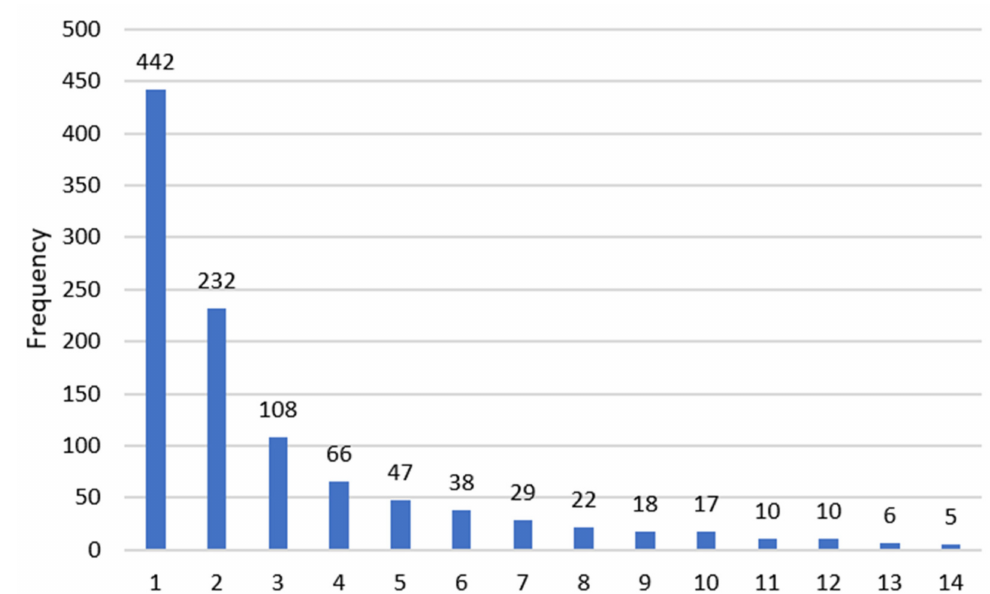
Figure 4. The main sources of information regarding such an event. 1—The Eduson